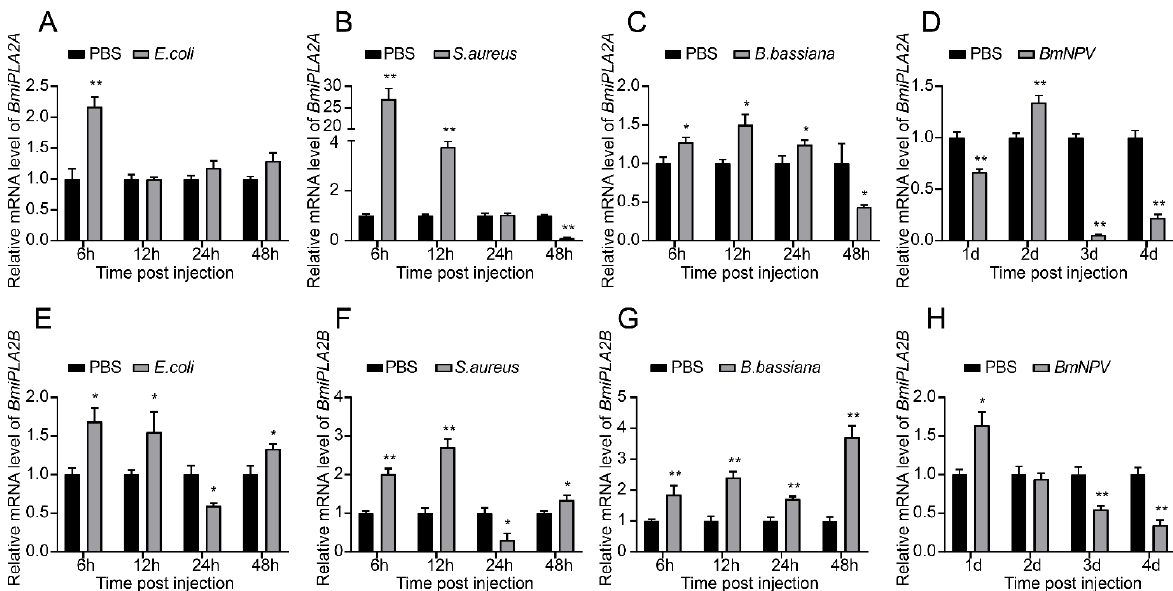
Figure 9. Temporal mRNA expression of BmiPLA2A and BmiPLA2B in fat bodies of immune chal- lenged silkworm larvae. The expression profiles at 6, 12, 24, and 48 h were analyzed after treatment with ( A,E ) Gram-negative bacteria Escherichia coli ( E. coli ), ( B,F ) Gram-positive bacteria Staphylococ- cus aureus ( S. aureus ), ( C,G ) fungus Beauveria bassiana ( B. bassiana ), and ( D,H ) virus Bombyx mori nu- cleopolyhedrovirus ( BmNPV ). The asterisks indicate the significance was statistically significant or ex- tremely significant (* p <0.05, ** p <0.01 and *** p <0.001).